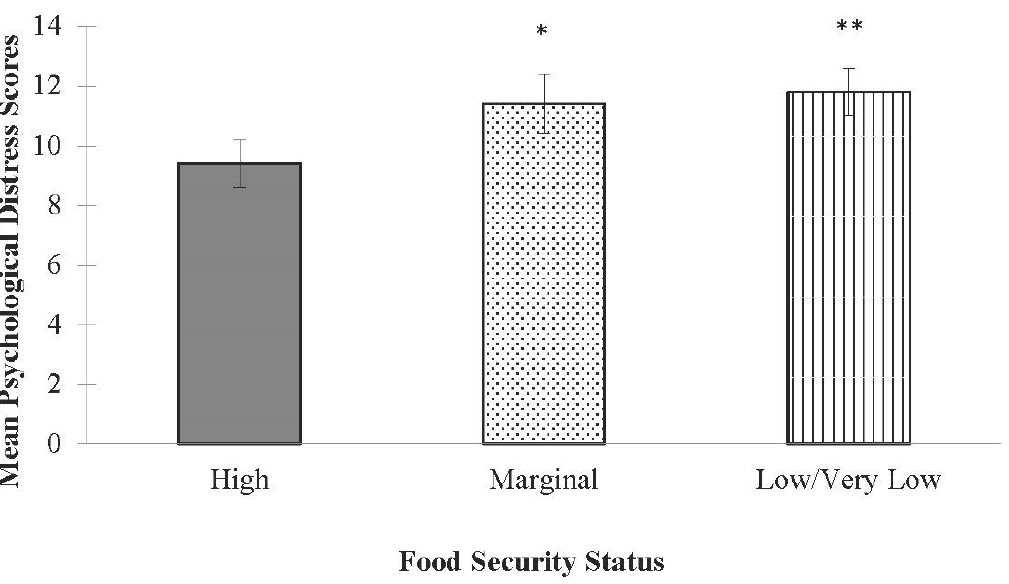
Figure 1. Adjusted mean (SE) psychological distress scores by food security status among full-time undergraduate students. * Indicates significantly different than high food security p < 0.05. ** Indicates significantly different than high food security p < 0.01.